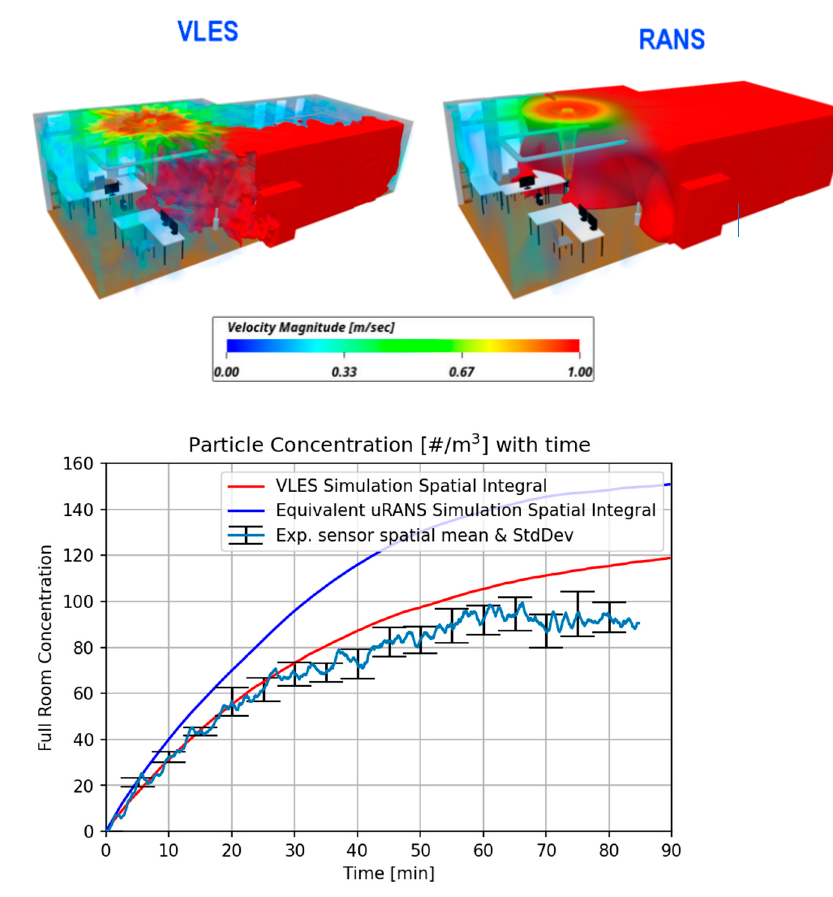
Figure 12. Scalar modelling concentration of particles inside room and comparison between VLES and equivalent uRANS. The red isosurface shows a water vapour mass fraction above 0.0008.